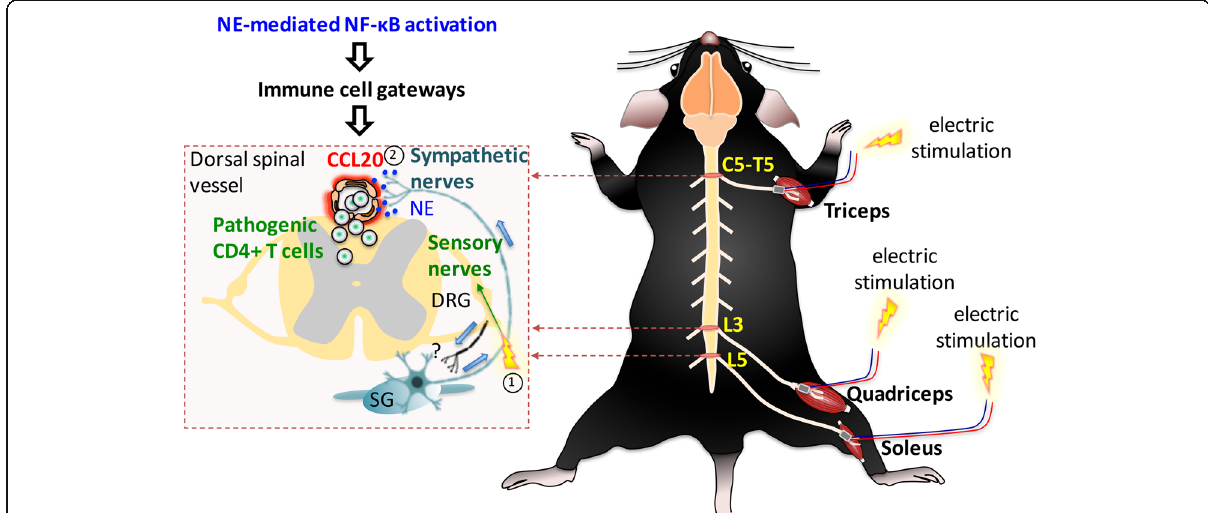
Fig. 2 Electronic gateway reflex. Artificial neural activations by weak electric stimulations can induce the gateway reflex at individual blood vessels in the CNS. Electric stimulations to the triceps (1) induce chemokine upregulation at the dorsal vessels of the fifth cervical (C5) to fifth thoracic (T5) spinal cord (2) via the inflammation amplifier, which is mediated by NE secretion. Likewise, electric stimulations to the quadriceps (1) trigger chemokine upregulation at the L3 dorsal vessels (2), whereas the L5 gateway is formed by electric stimulation to the soleus muscles. Abbreviations: DRG, dorsal root ganglion; SG, sympathetic ganglion; NE,